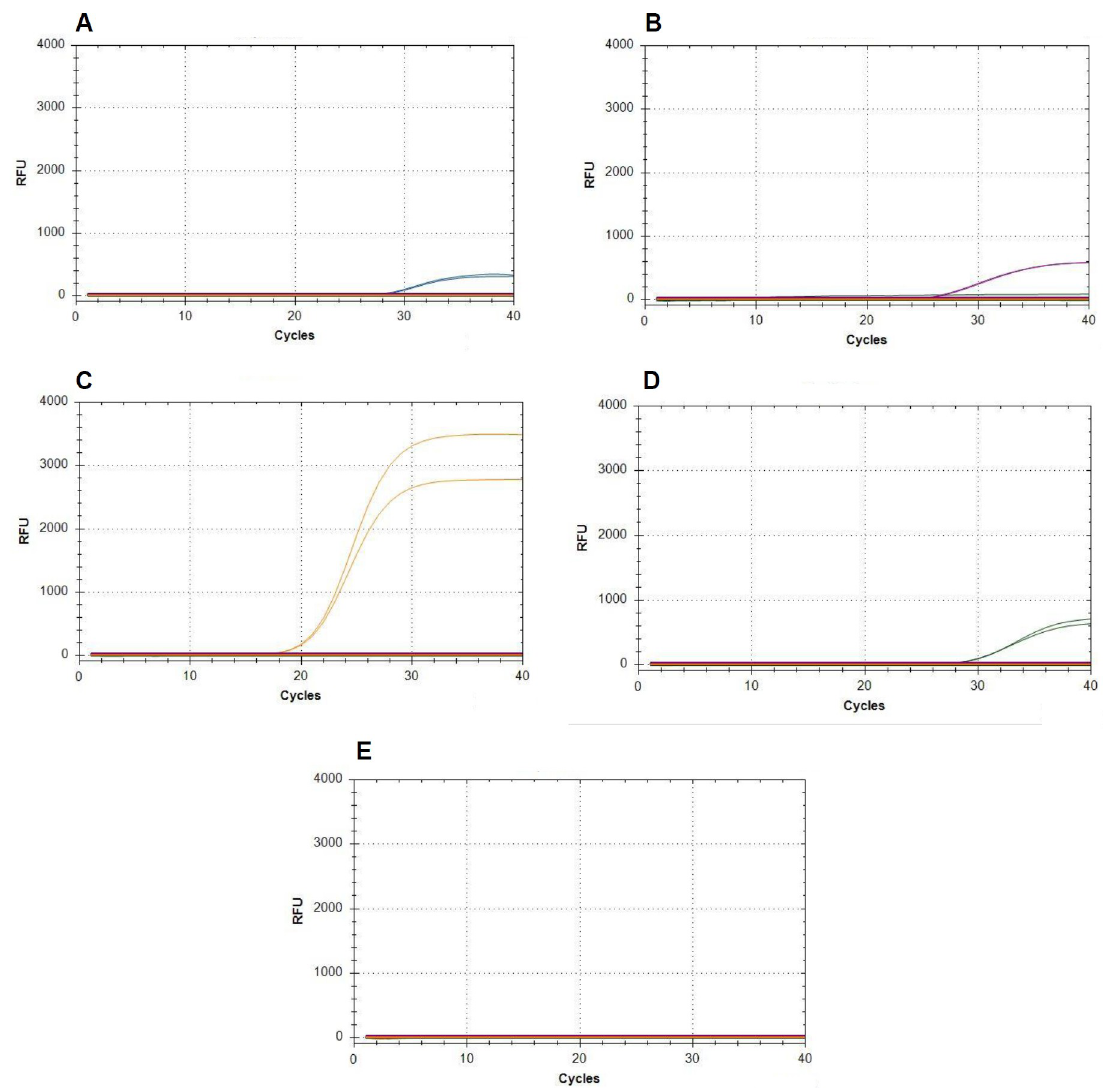
Fig 2. Specificity of the quadruplex real-time PCR assay. Since the graphs for different isolates of the target species and also of all the non-target species are highly similar, only one representative graph is shown each. 0.4 ng DNA from (A) D . longicolla DPC_HOH28, (B) D . caulivora DPC_HOH2, (C) D . eres DPC_HOH3, and (D) D . novem DPC_HOH15 was added individually to the mix that contained all four primer-probe sets. (E) shows the result for the non-target species D . aspalathi , D . foeniculina , Cercospora kikuchii , Fusarium solani , Alternaria sp ., S . sclerotiorum DSMZ, or S . sclerotiorum IZS, Colletotrichum truncatum , F . tricinctum , Phakopsora pachyrhizi , Uromyces fabae , Uromyces appendiculatus , healthy soybean leaf, and healthy soybean stem. For these species and also D . longicolla isolate PL-157a and D . eres isolate PS-74 DNA amounts varied between 350 and 2,500